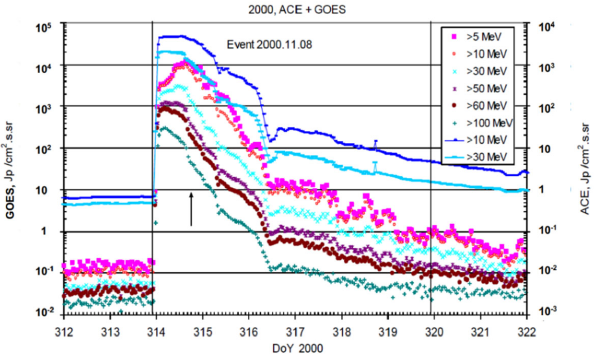
Figure 1. Time profiles of the proton fluxes for the event of 8 November 2000 [35].